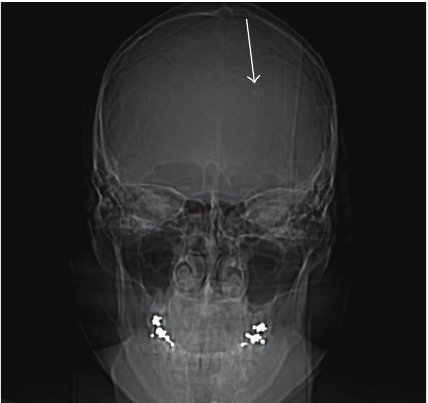
Figure 6: Anteroposterior radiograph of the skull demonstrating a focus of calcification to the left of the midline